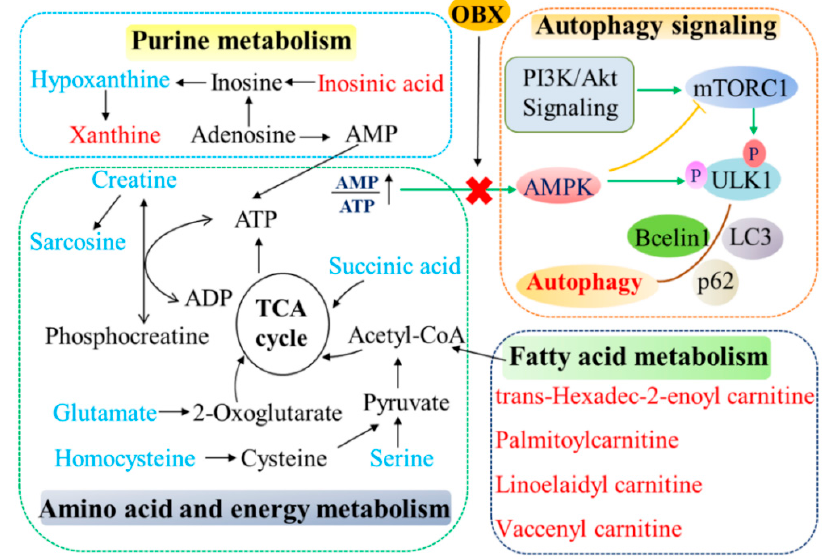
Figure 8. The correlation network of altered metabolites and autophagy in the hippocampus of OBX rats. The metabolites marked in blue denote decreased biomarkers and those in red indicate the increased ones.